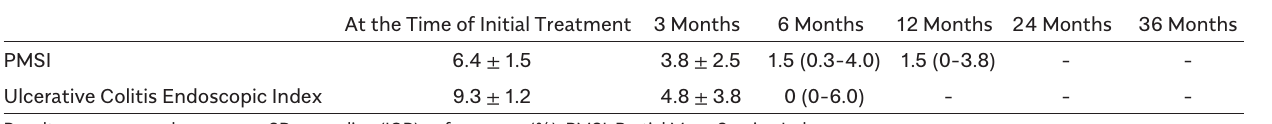
Table 3. International Scores for Ulcerative Colitis